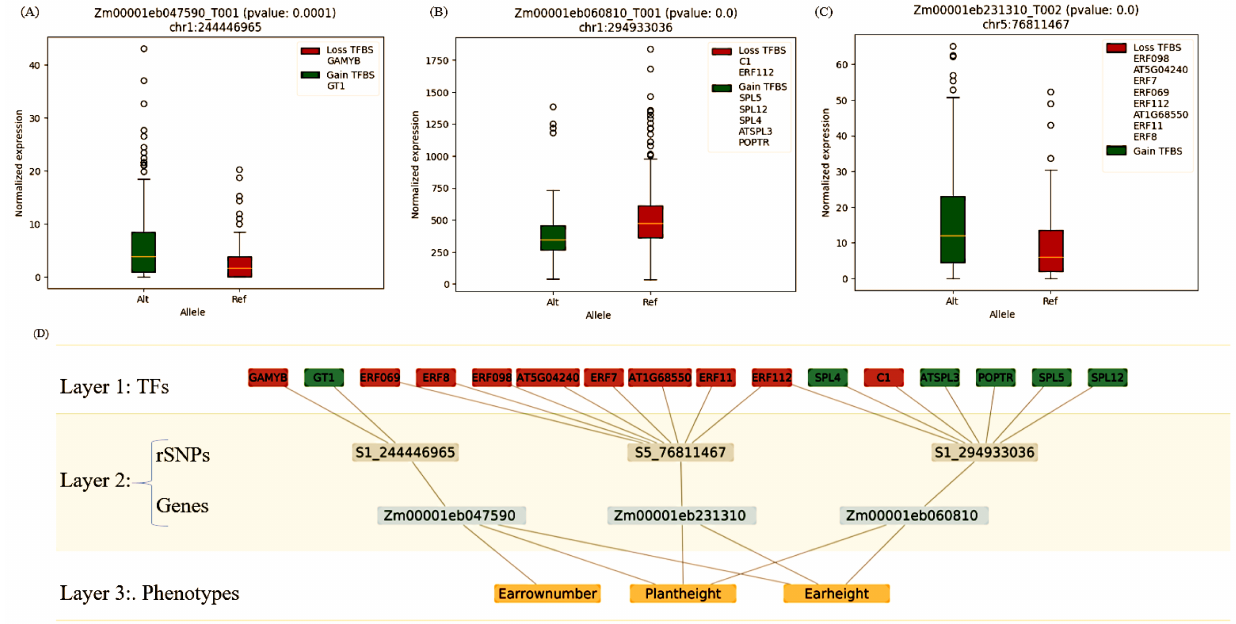
Figure 4. Hierarchical network model constructed using Cluster-7 to elucidate the complex interplay among TFs − rSNPs(genes) − Phenotypes. ( A – C ) show the significant changes in the gene expression values resulting from the consequences of pleiotropic rSNPs. ( D ) Hierarchical network model with three